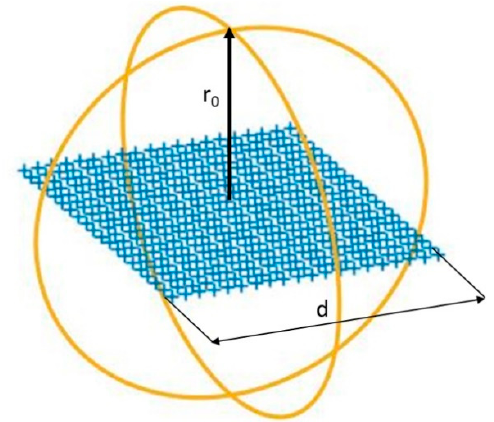
Figure 5. Simulated model of DUT for different electrical size.